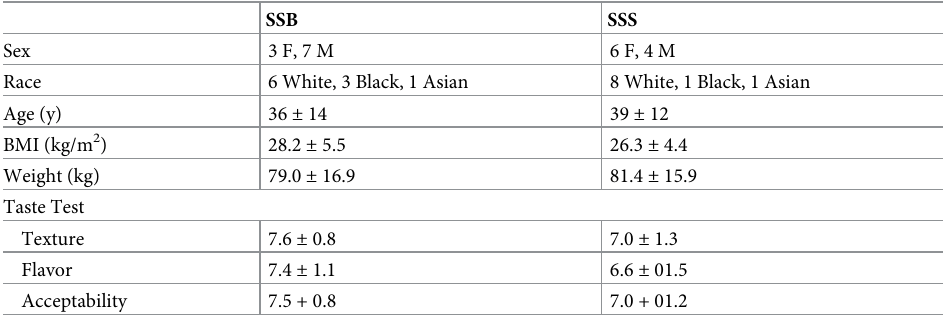
Table 1. Participant